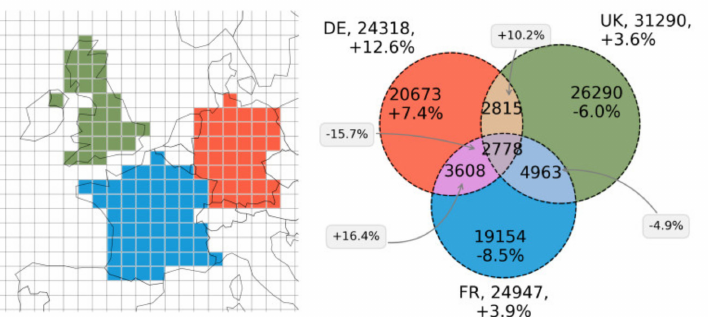
Figure 7. Analyzing spatial relationships with HLL intersection, based on incremental union of user sets from benchmark data (100 km-grid) for France, Germany and the United Kingdom ( left ). The Venn Diagram ( right ) shows estimation of common user counts for di ff erent groups, and the percentage of error compared to raw data. The same graphic, generated for 50 km grid size, is available in Figure